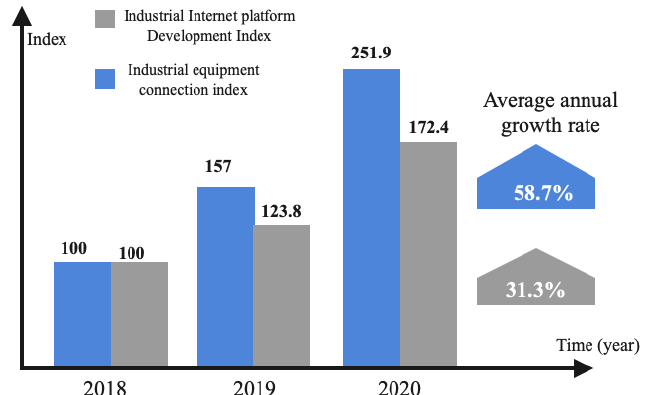
Figure 3. Change trend of industrial equipment connection level in 2018–2020.